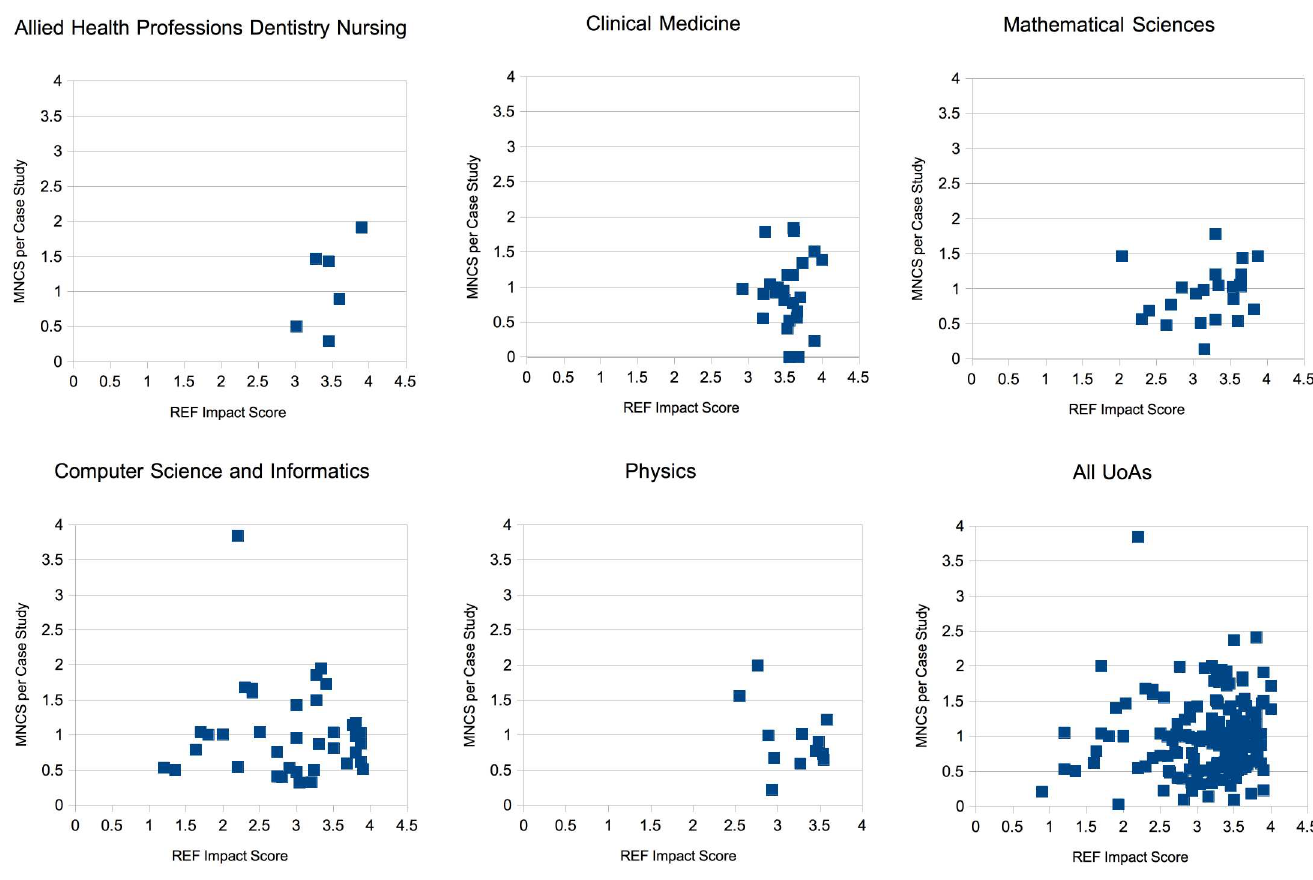
Fig 4. AverageMNCS per REF case study vs REF casestudy